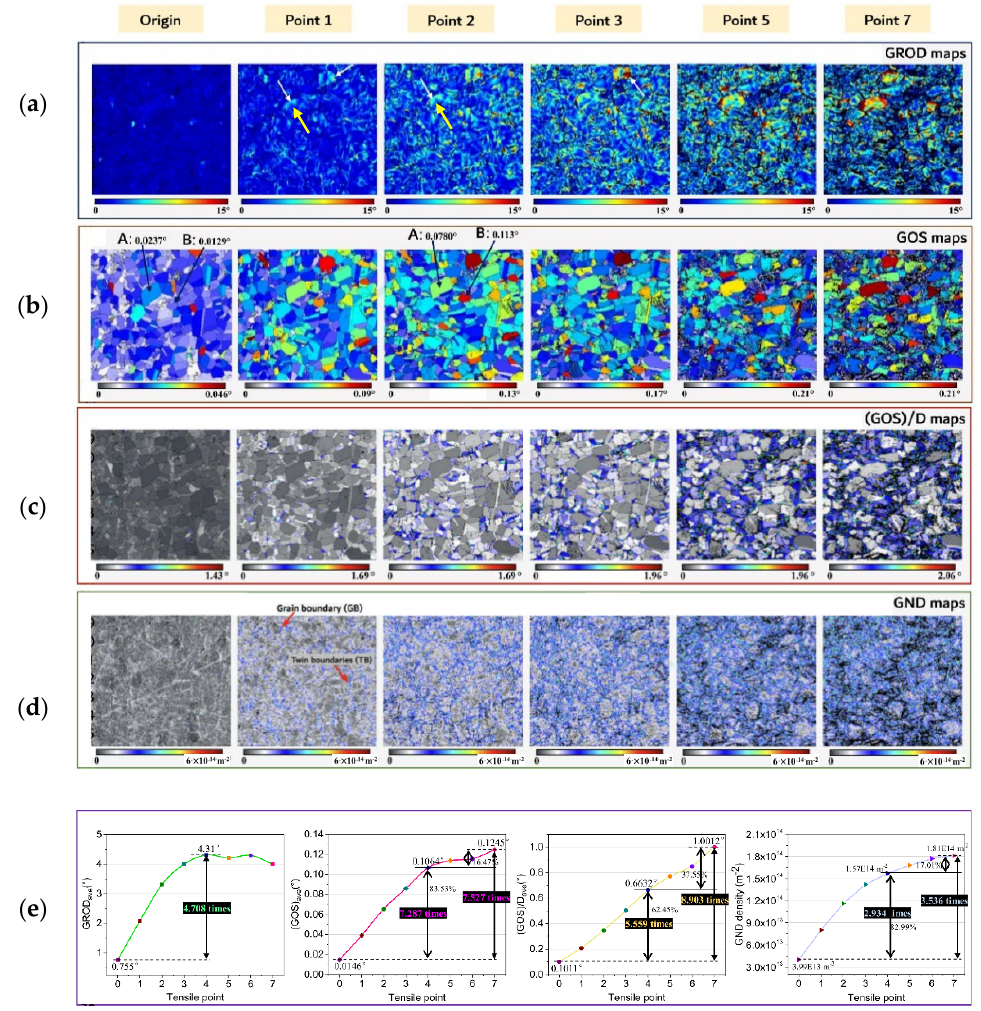
Figure 2. The EBSD measurements of the 316 steel with different plastic strain. ( a ) GROD maps; ( b ) GOS maps; ( c ) (GOS)/D maps; ( d ) GND density maps; ( e ) The variation of above parameters in 316 steel during the tensile process.